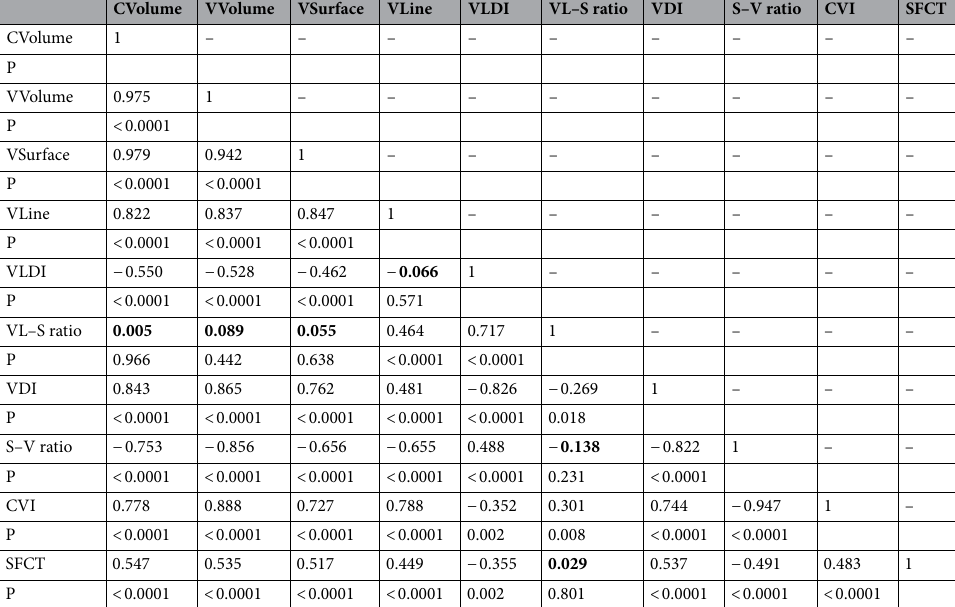
Table 3. The correlation table of each parameter. Bold characters indicate the correlation is P > 0.05.